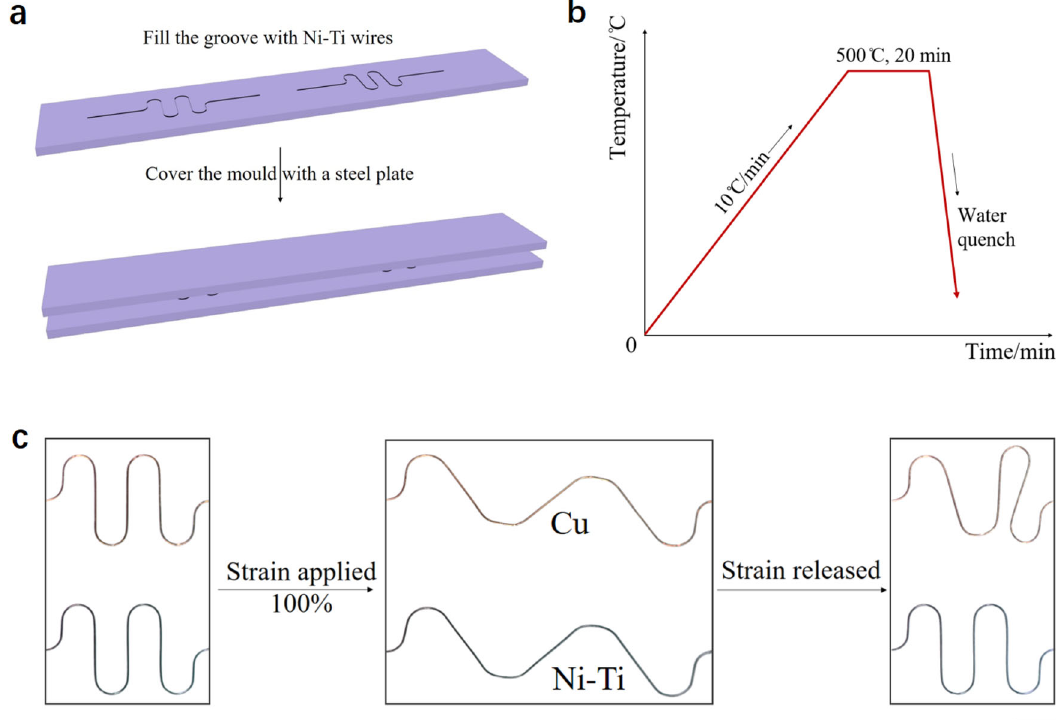
Fig. 2 Comparison of mechanical properties. a Schematic illustration of the formation process of the Ni-Ti serpentine interconnects by mold. b Diagram of the heat treatment for setting the Ni-Ti wires into serpentine interconnects. c A comparison of elastic stretchability between Cu and Ni-Ti serpentine interconnects. The right column shows the interconnect structures after releasing 100% applied strain. The scale bar is 2